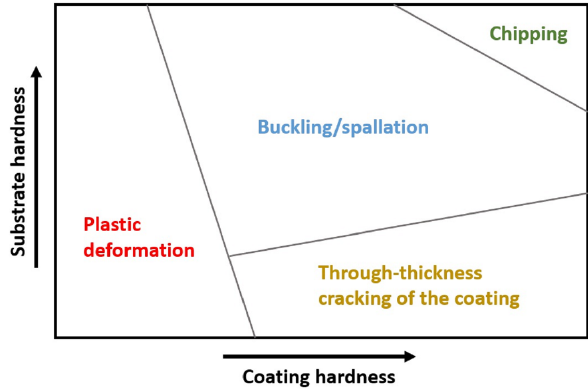
Figure 8: Schematic representation of main coating damage modes as a function of coating and substrate hardness (based on [56, 63]).